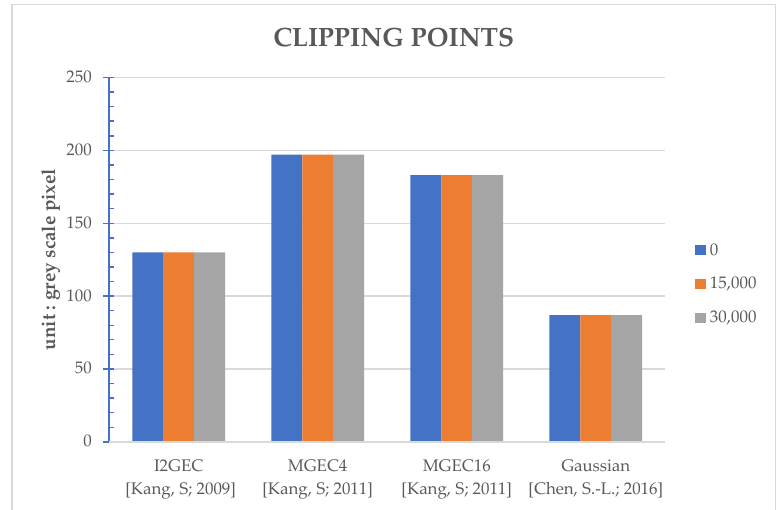
Figure 5. Bar comparisons of power (watts) of different algorithms at different thresholds.